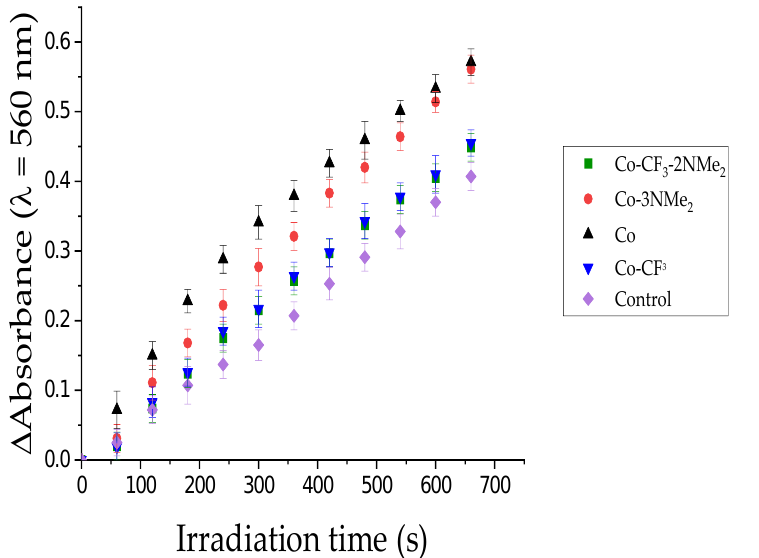
Figure 3. Determination of O 2 •− generation by NBT method, following the increase of the diformazan absorption band at 560 nm after different irradiation times: NBT + NADH + Co (black), NBT + NADH + Co-3NMe 2 (red), NBT + NADH + Co-CF 3 (blue), NBT + NADH + Co-CF 3 -2NMe 2 (green), NBT + NADH (purple). Samples contain NBT (0.2 mM), NADH (0.5 mM), and PS (A = 0.1 at 628 nm) in DMF:water (9:1), λ irr = 628